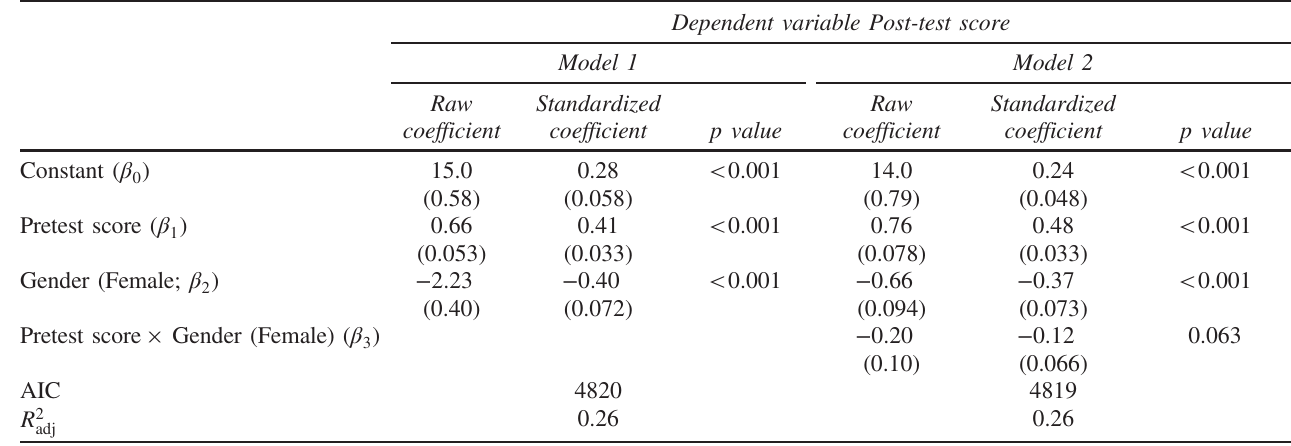
TABLE I. Raw and standardized coefficients for two MLR models using the PCSSW dataset. Model 2 includes an interaction term between pretest score and gender, allowing the relationship between pretest and post-test scores to vary across gender. There is essentially no difference in AIC or R 2 between the two models, so the effect of the interaction term is